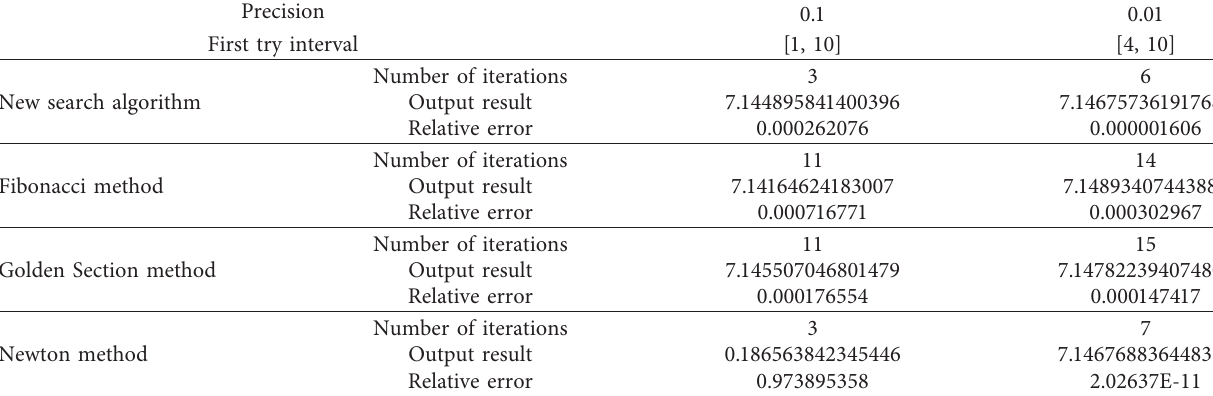
Table 1: Comparison of the new algorithm with the Golden Section method, Fibonacci method, and Newton